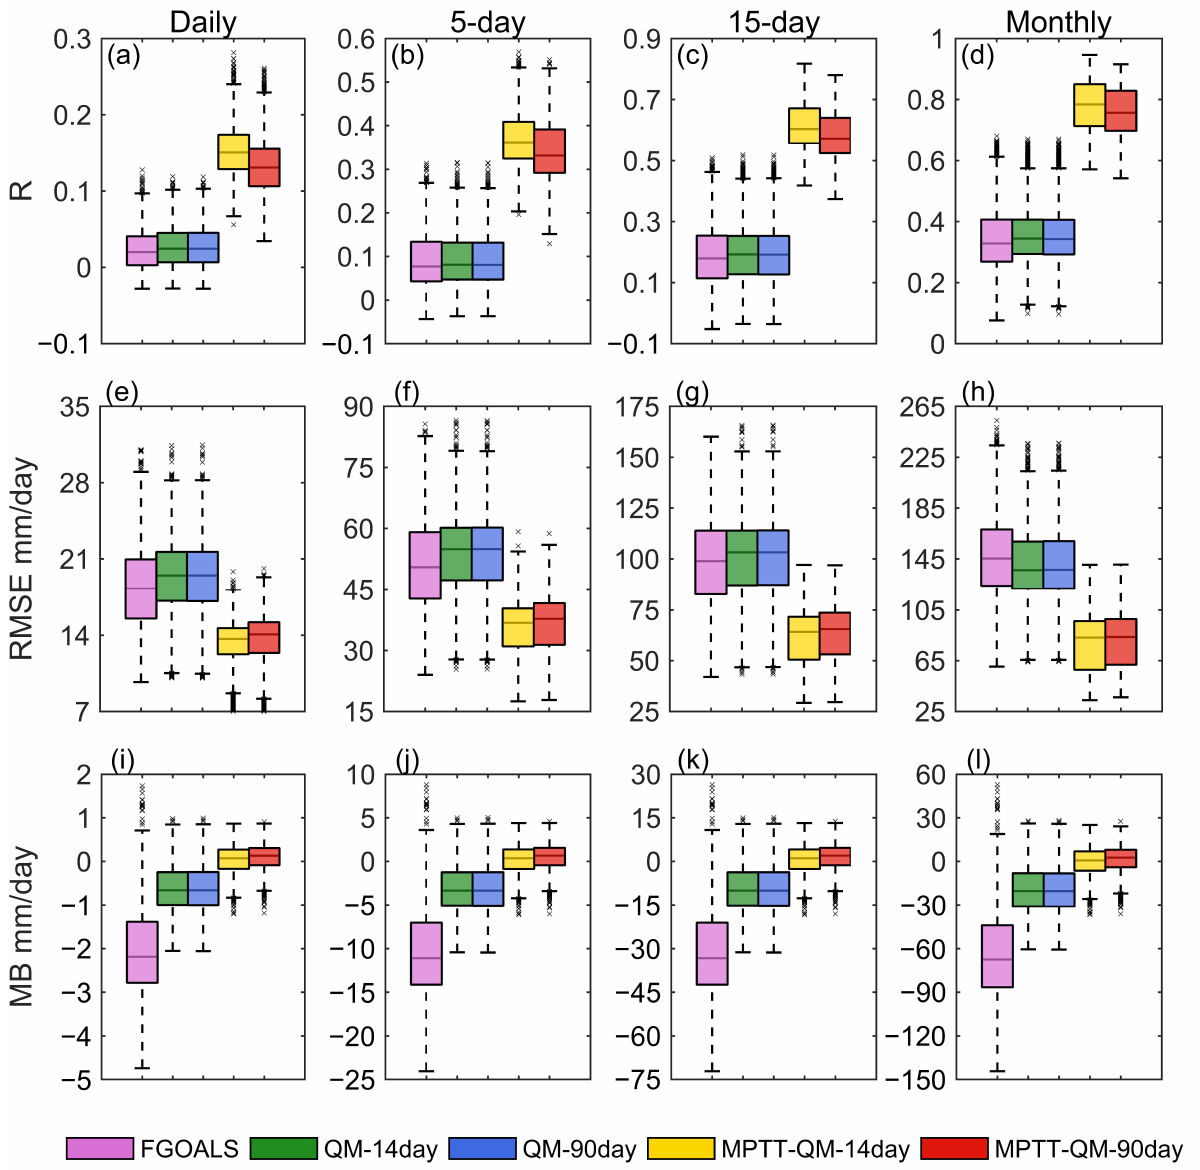
Figure 6. Boxplots of correlation coefficient (R), root mean square error (RMSE), and mean bias (MB) for five precipitation products over four different time scales: daily, 5-day, 15-day, and monthly. ( a – d ) represent the boxplot of R, ( e – h ) represent the boxplot of RMSE, and ( i – l ) represent the